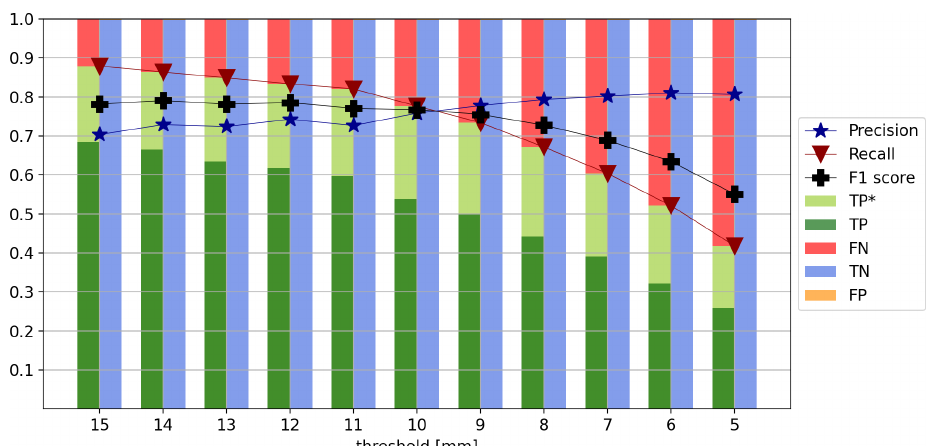
Figure 11. Classification result for testing stations for different displacement size thresholds. A detailed description of the figure content and acronyms are presented in the captions of Figures 4 and